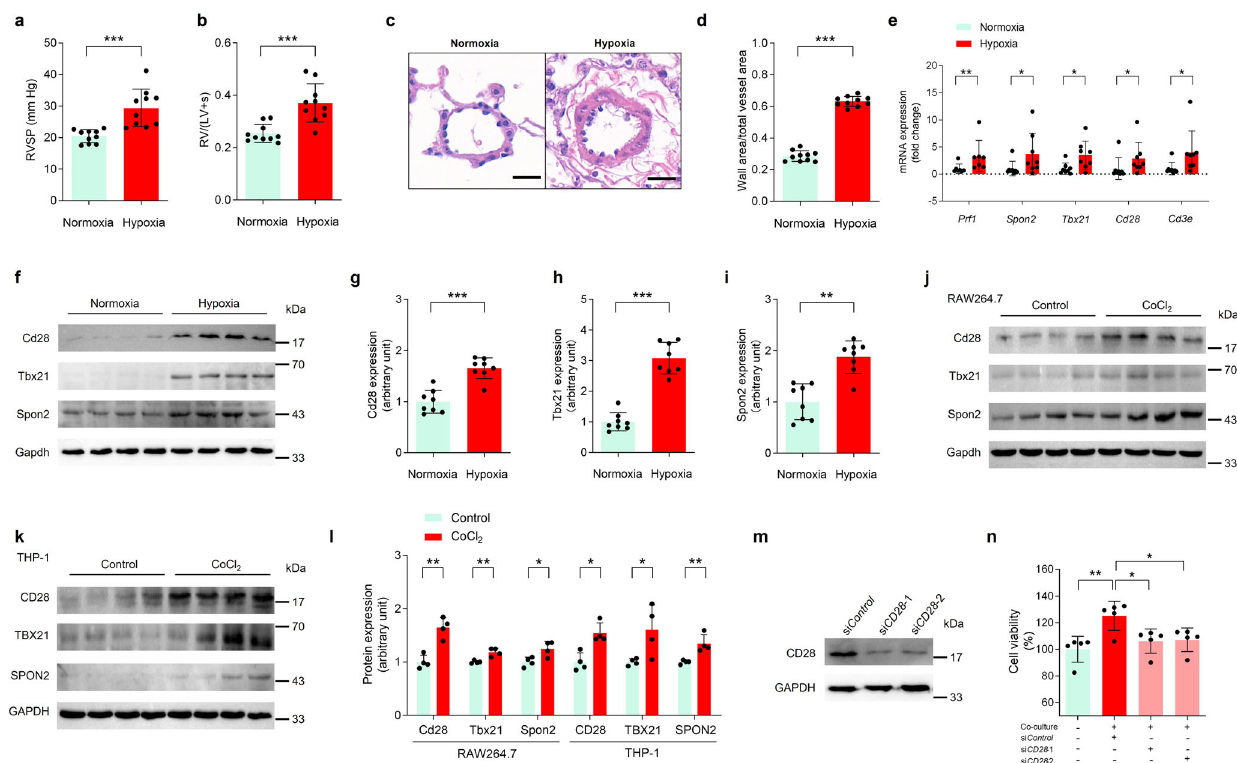
Fig. 5 | Gene-function validation in hypoxic PH mice. C57BL/6 mice exposed to hypoxia (10% O 2 ) for 4 weeks exhibited higher RVSP ( a ) and RVHI ( b ) compared to thatofmiceinnormoxia(21%O 2 )( n =10forpergroup,*** p <0.001;Student ’ s t test. Da t a were presented as mean±SD). c Representative images of hematoxylin and eosin (H&E) staining of lung tissues from mice under normoxic or hypoxic condi- tion. Scale bars, 20 μ m. d Assessment of pulmonary vascular remodeling by determination of the ratio of the media cross-sectional area to the total vessel cross-sectional area in each group ( n =10 for per group, *** p <0.001; Student ’ s t test. Data were presented as mean±SD). e The expression of Prf1 , Spon2 , Tbx21 , Cd28 and Cd3e in lung tissues of the mice under normoxic or hypoxic condition at mRNAlevels( n =7 – 8forpergroup,* p <0.05,** p <0.01;Student ’ s t test. Datawere presented as mean±SD). f – i Representative images of immunoblottings and the quanti fi cationoftheexpressionofCd28( g ),Spon2( h )andTbx21( i )inlungtissues of the control mice and hypoxic PH mice at protein levels ( n =8 for per group, ** p <0.01, *** p <0.001; Student ’ s t test. Data were presented as mean±SD).